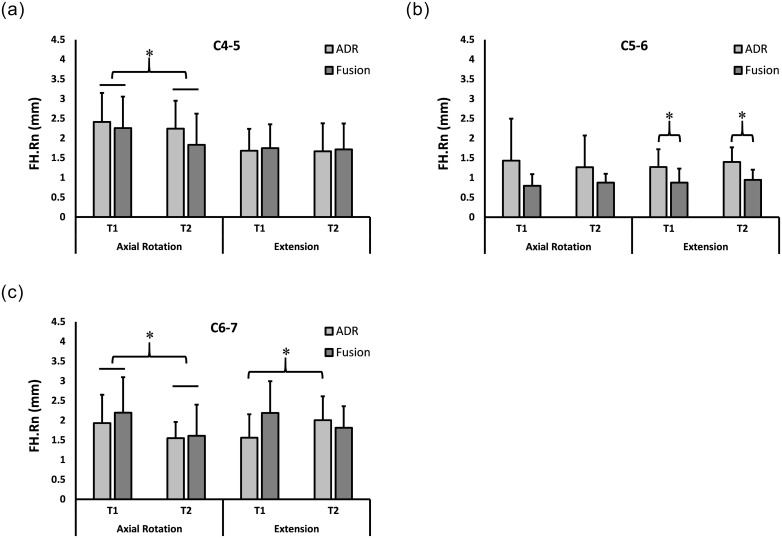
Foraminal Height Range (FH.Rn) at 2y and 6.5y.Range of foraminal height (FH.Rn) (Mean + SD) during neck axial rotation (left) and extension (right) movements at C4-5 (A), C5-6 (B), and C6-7 (C). * Statistically significant difference.